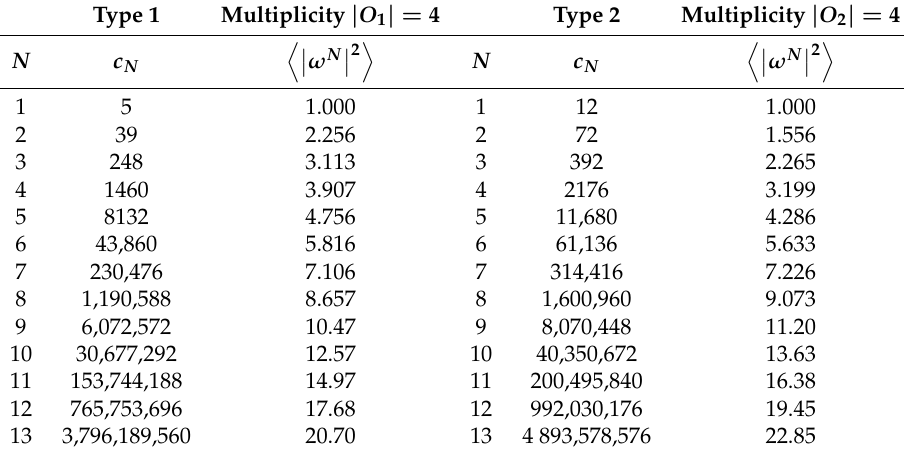
Table A5. FCC lattice, tube cross section 1.0